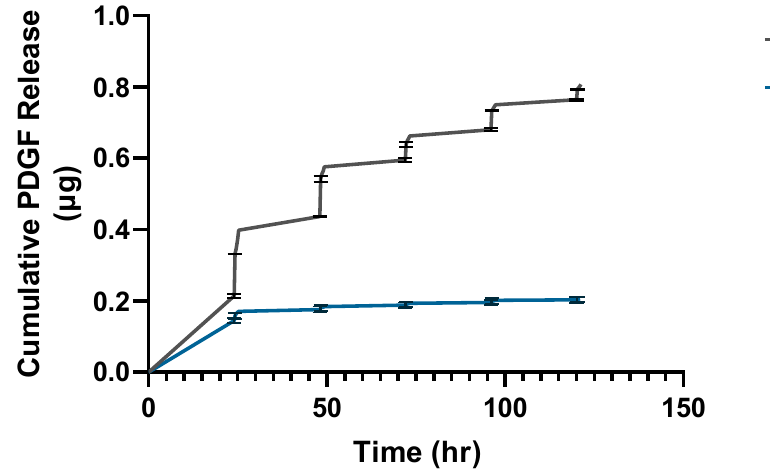
Figure 5. The cumulative release ( µ g) of PDGF-BB (24.3 kDa) from chitosan-coated substrates triggered by heat exposure. Heating cycles occurred every 24 h, starting at t = 24 h. After 5 heating cycles, nearly 60% of the PDGF-BB remained on the substrate. The negative control group ( − x-linker) measured the growth factor–oligo conjugate that had non-specifically adsorbed to the substrate, and nearly all of it was collected during the first 24 h ( n =